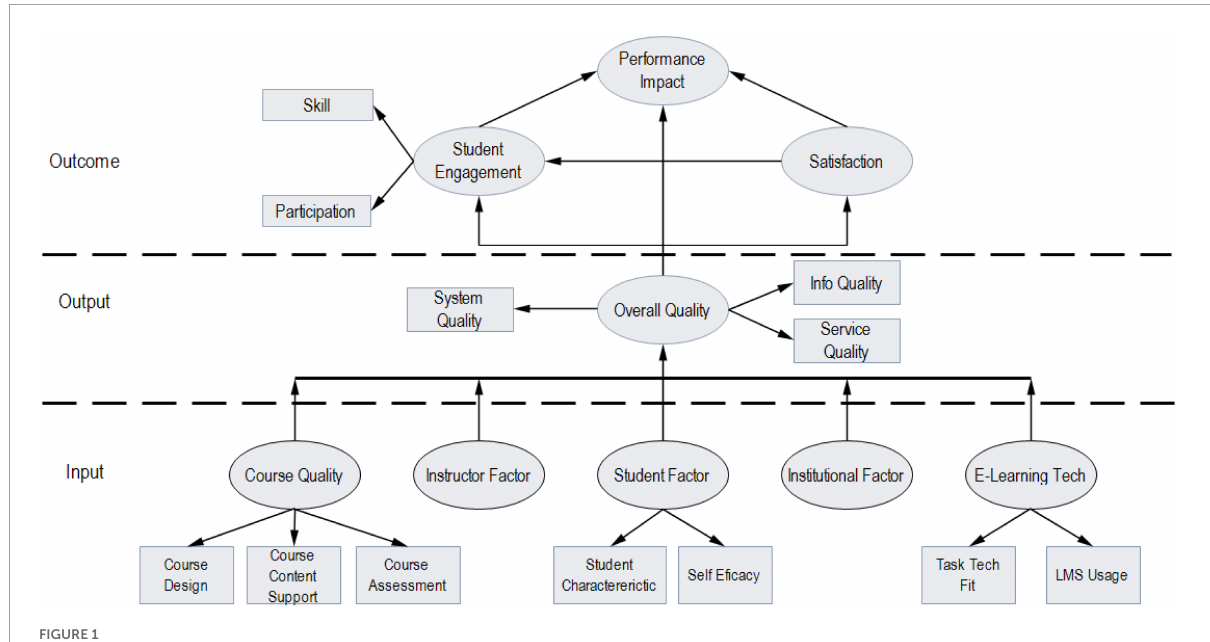
FIGURE1 Framework of student performance in online learning